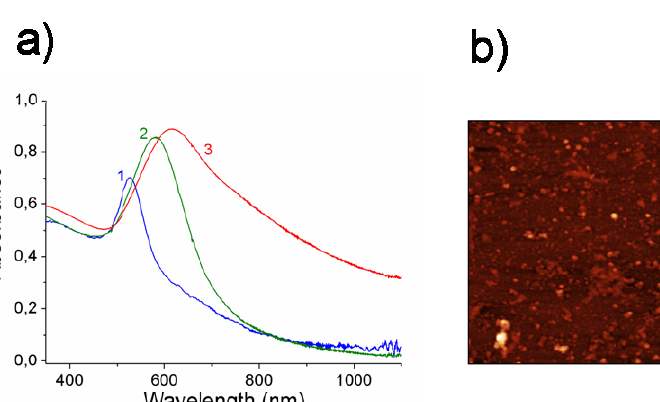
Figure 4. ( a ) UV-vis absorption spectra of the polyelectrolyte films with one layer of: 1—NNPs; 2—PNPs; 3—hc-PNPs; graphs are normalized to bring peaks for all